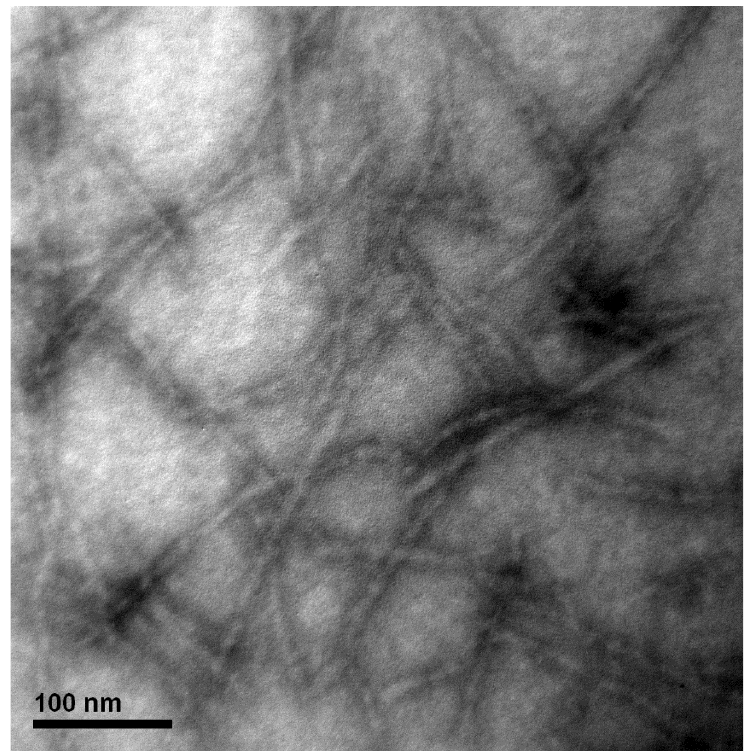
Figure 2. Transmission electron (TEM) micrograph of the negatively stained whey protein isolate amyloid fibrils. (The magnification = 200k×; scale bar = 100 nm).